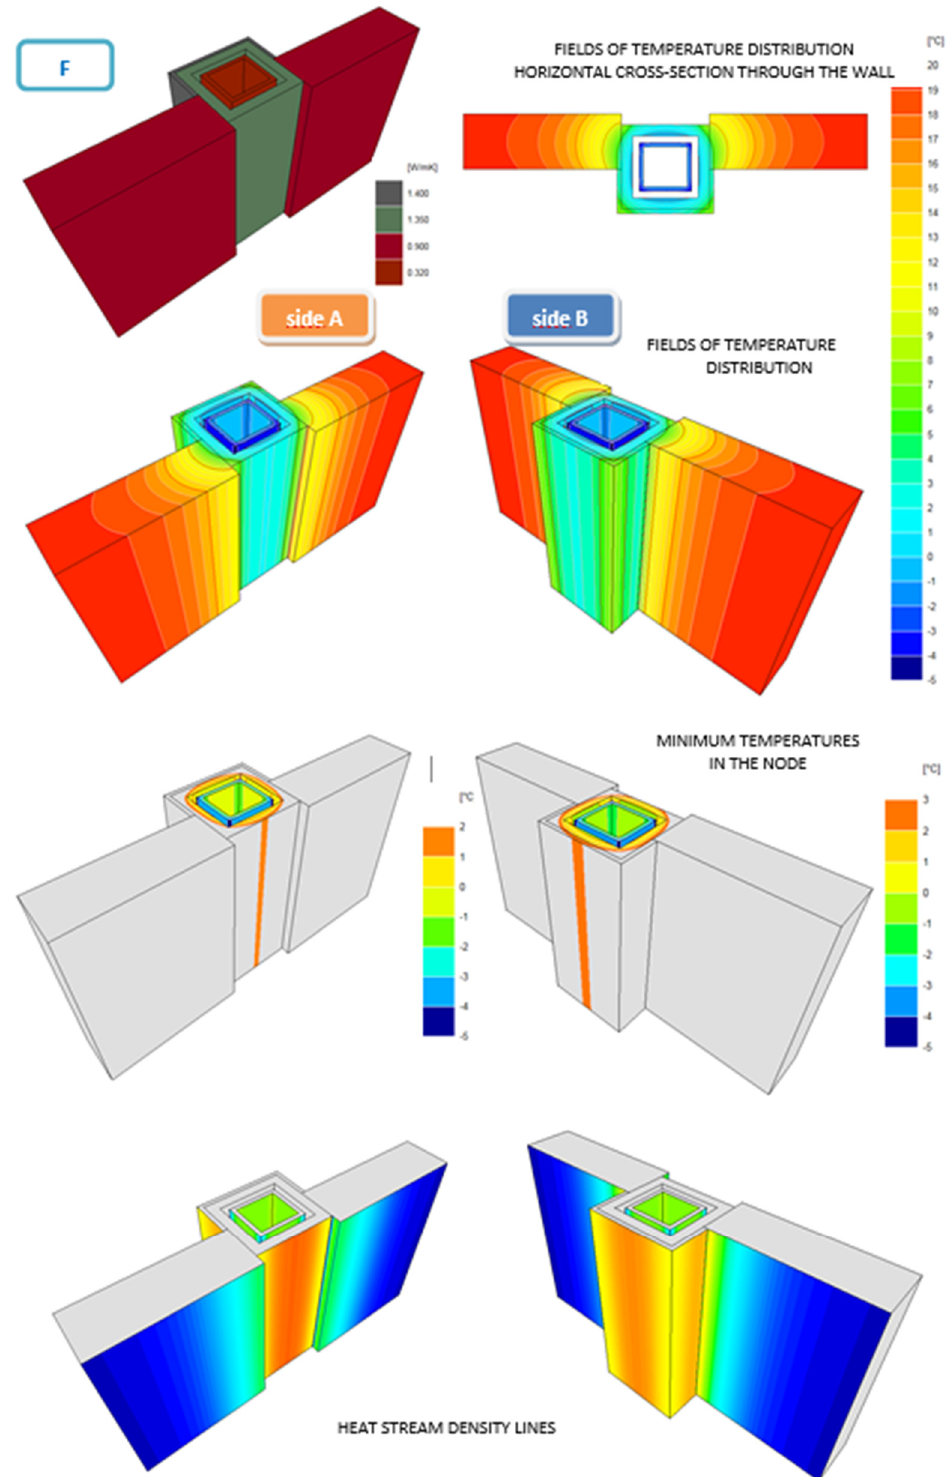
Figure A6. Scheme F: distribution of isotherm field, minimum surface temperature, and heat flux Figure A6. Scheme E: distribution of isotherm field, minimum surface temperature, and heat flux distribution.